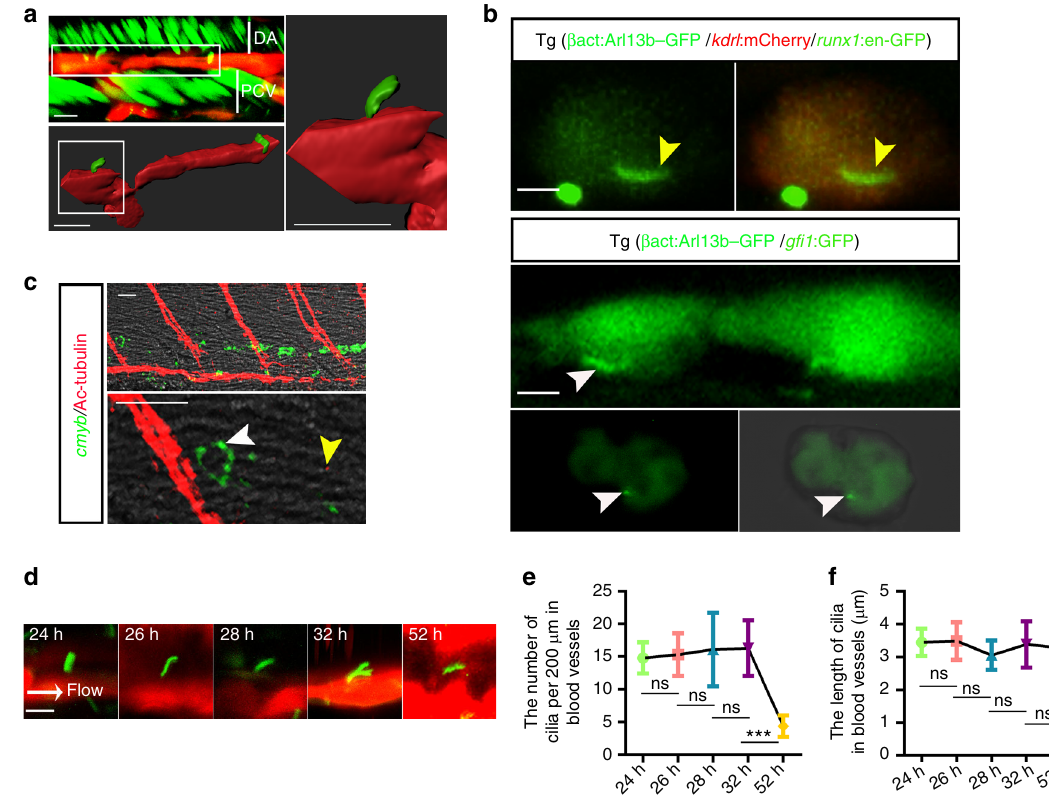
Fig. 1 Ciliogenesis occurs in vascular endothelial cells (ECs) in AGM. a Three-dimension (3D) confocal imaging showing cilia on ECs in the AGM region using Tg( β act:Arl13b – GFP/ kdrl :mCherry/ runx1 :en-GFP) line at 28 hpf. White squares indicate the ECs with cilia. White bars denote DA or PCV region. DA dorsal aorta, PCV posterior cardinal vein. Scale bars, 10 µ m. b The live confocal imaging of kdrl + / runx1 + or g fi 1 + HE cells in Tg( β act:Arl13b – GFP/ kdrl : mCherry/ runx1 :en-GFP) (upper panel) or Tg( β act:Arl13b – GFP/ g fi 1 :GFP) at 28 hpf (middle panel). The imaging of g fi 1 + HE cells sorted by fl uorescence- activated cell sorting of dissected trunk region in Tg ( g fi 1 :GFP/ β act:Arl13b – GFP) embryos (lower panel). Yellow arrowheads indicate primary cilia in kdrl + / runx1 + cells; white arrowheads indicate primary cilia in g fi 1 + HE cells. Scale bars, 5 µ m. c Fluorescence in situ hybridization (FISH) result showing the cmyb expression and Ac-tubulin staining showing the cilia in the aorta-gonad-mesonephros (AGM) region at 48 hpf. Yellow arrowhead indicates primary cilia and the white arrowhead indicates the cmyb + HSPC in the AGM region. The cmyb probe was used to examine cmyb expression in Tg ( cmyb :EGFP) embryos by FISH. Scale bars, 20 µ m. d The live confocal imaging of cilia with kdrl :mCherry/ β act:Arl13b – GFP double-transgenic line. White arrow denotes the blood fl ow direction. Scale bar, 5 µ m. e , f The statistical data shows the primary cilia number ( e ) and length ( f ) in blood vessels in the AGM region in wild-type embryos. The cilia length presented in each embryo was the average length of all the cilia in the DA of the AGM region calculated per 200 µ m. Data represent the analysis results of one-way ANOVA – Sidak test. Error bars, mean ± s.d., n = 10 embryos. ns non-signi fi cant, *** P <